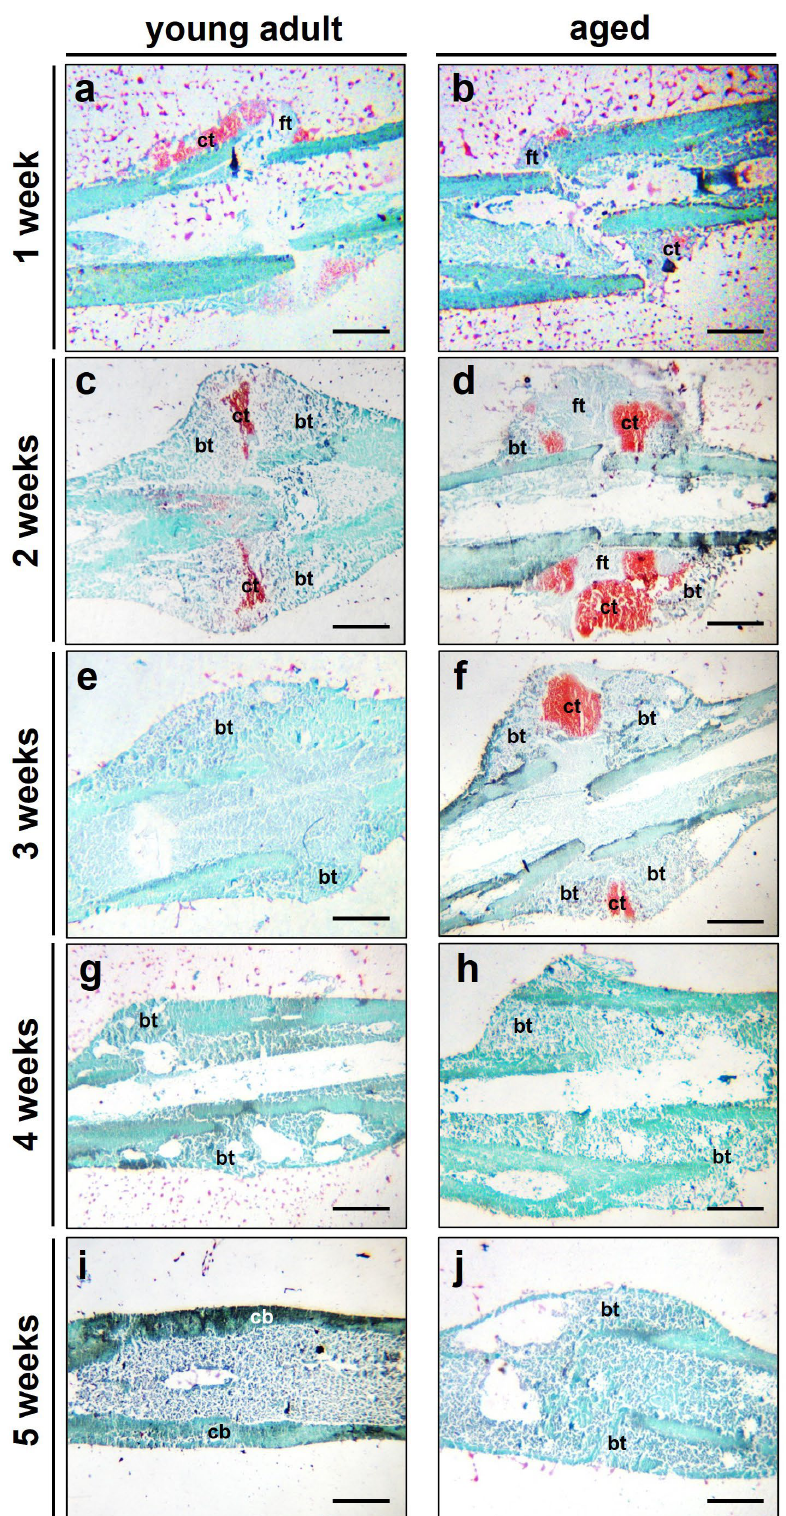
Figure 5. ( a – j ) Representative histological images (Safranin-O-staining) of fractured femora at 1 ( a , b ), 2 ( c , d ), 3 ( e , f ), 4 ( g , h ) and 5 weeks ( i , j ) after fracture in young adult ( a , c , e , g , i ) and aged ( b , d , f , h , j ) CD-1 mice (ct: cartilaginous tissue, ft: fibrous tissue, bt: bone tissue, cb: cortical bone). Scale bars: 1